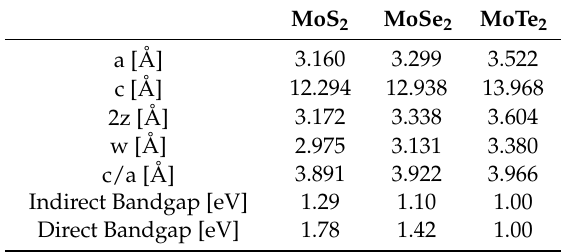
Table 1. Cell and structural parameters and measured bandgaps of 2H polytype Mo dichalcogenides